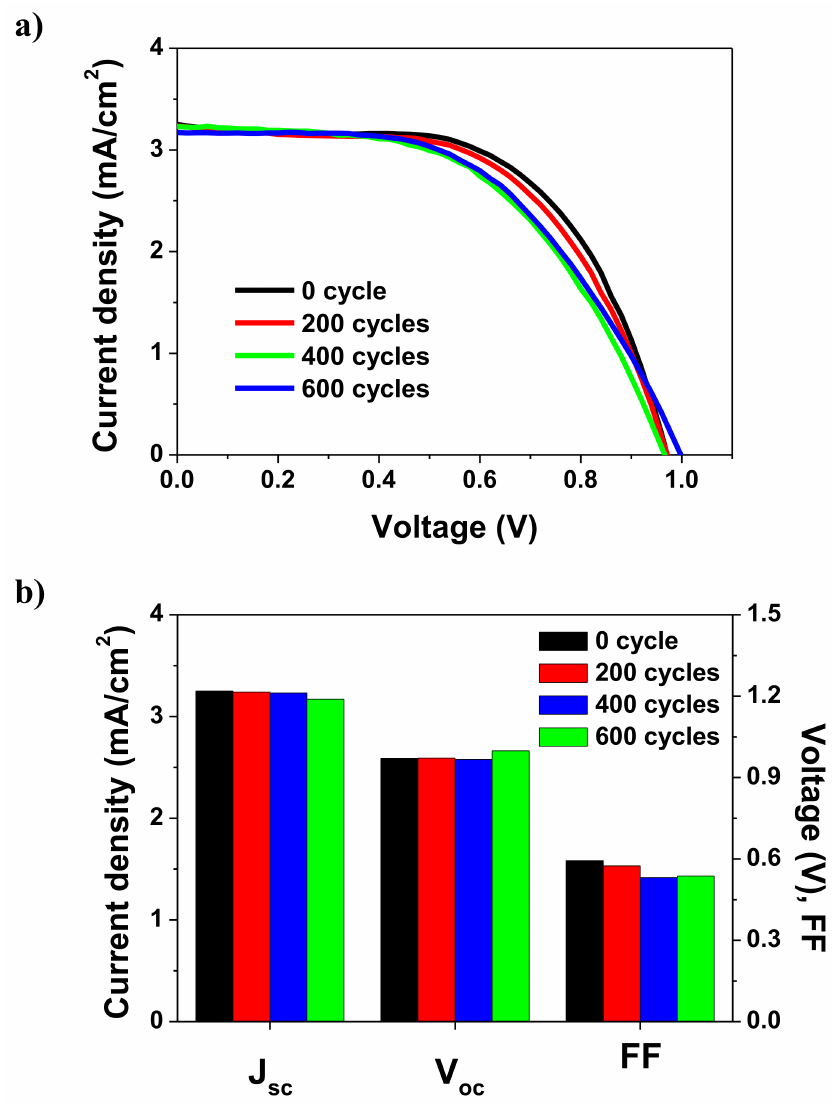
Figure 6. ( a ) Current–voltage curves and ( b ) variations in the current density (J sc ), open-circuit voltage (V oc ), and fill factor (FF) of flexible perovskite solar cells based on mesoporous TiO 2 sintered at a low temperature and fabricated on a polyethylene naphthalate film, as functions of the bending